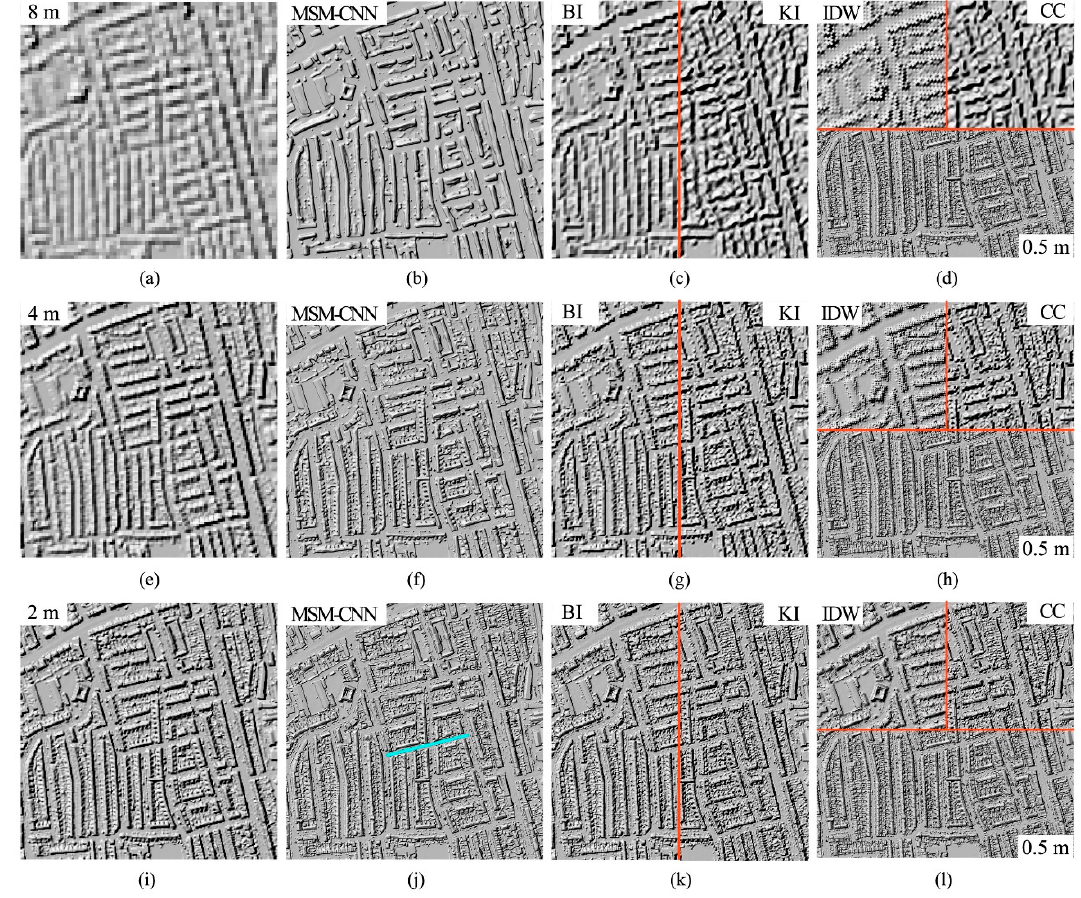
Figure 6. Reconstructed results in the study area (zoom-in): ( a , e , i ) the low-resolution urban DEMs of 8, 4, and 2 m; ( b , f , j ) the results reconstructed by MSM-CNN using the respective low-resolution DEMs at the same row; ( c , g , k ) from bilinear interpolation (BI; the left part) and kriging interpolation (KI; the right part); ( d , h , l ) results from inverse distance weighting (IDW; the upper-left part) and cubic convolution (CC; the upper-right part), and the reference urban DEM at 0.5 m (the bottom part). The highlight line in ( j ) is the road centerline for comparing reconstructed road profiles later.